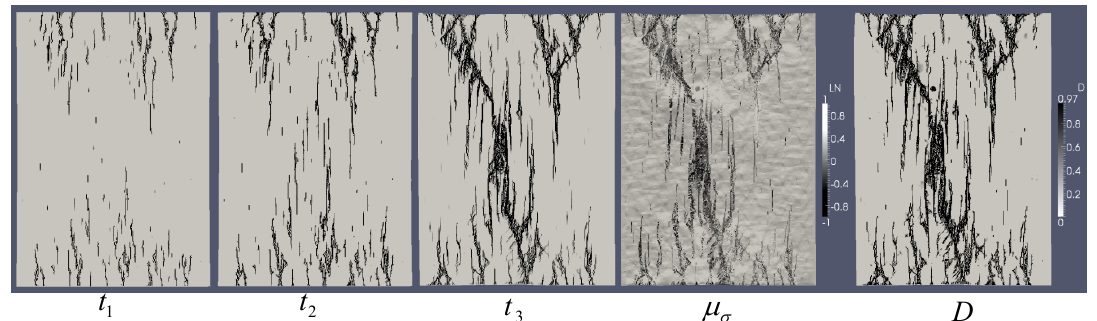
 ), damage function ( D ) in the 